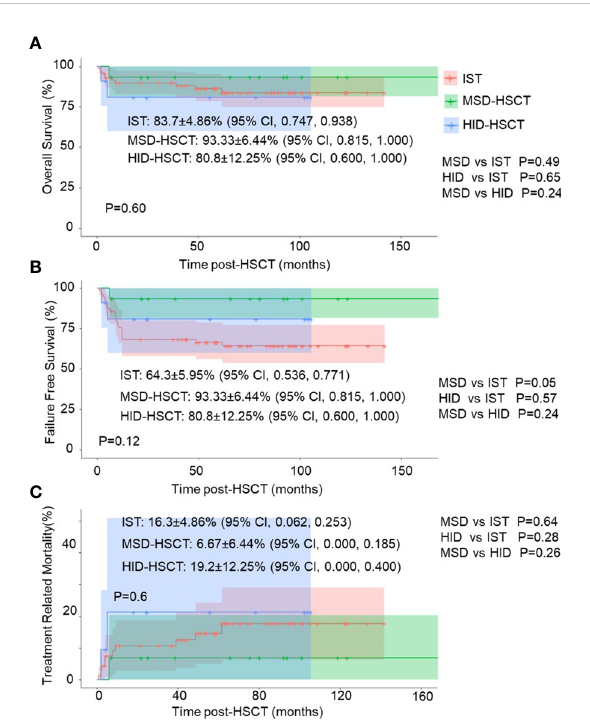
FIGURE 2 Survival analysis of HAAA patients receiving different treatments: IST, MSD-HSCT, and HID-HSCT. (A) Overall survival (OS); (B) Failure-free- survival (FFS); (C) non-relapse mortality (TRM) in different groups.